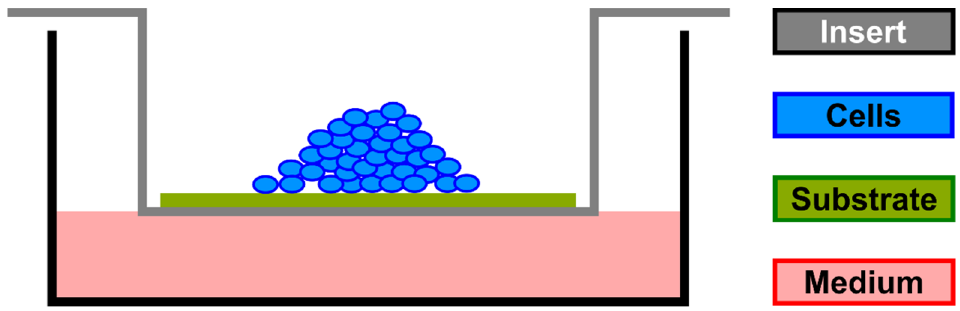
Figure 2. Schematic air-lift model *Substrate A (NPCM +/ − xHyA); B (RCCM +/ − xHyA).